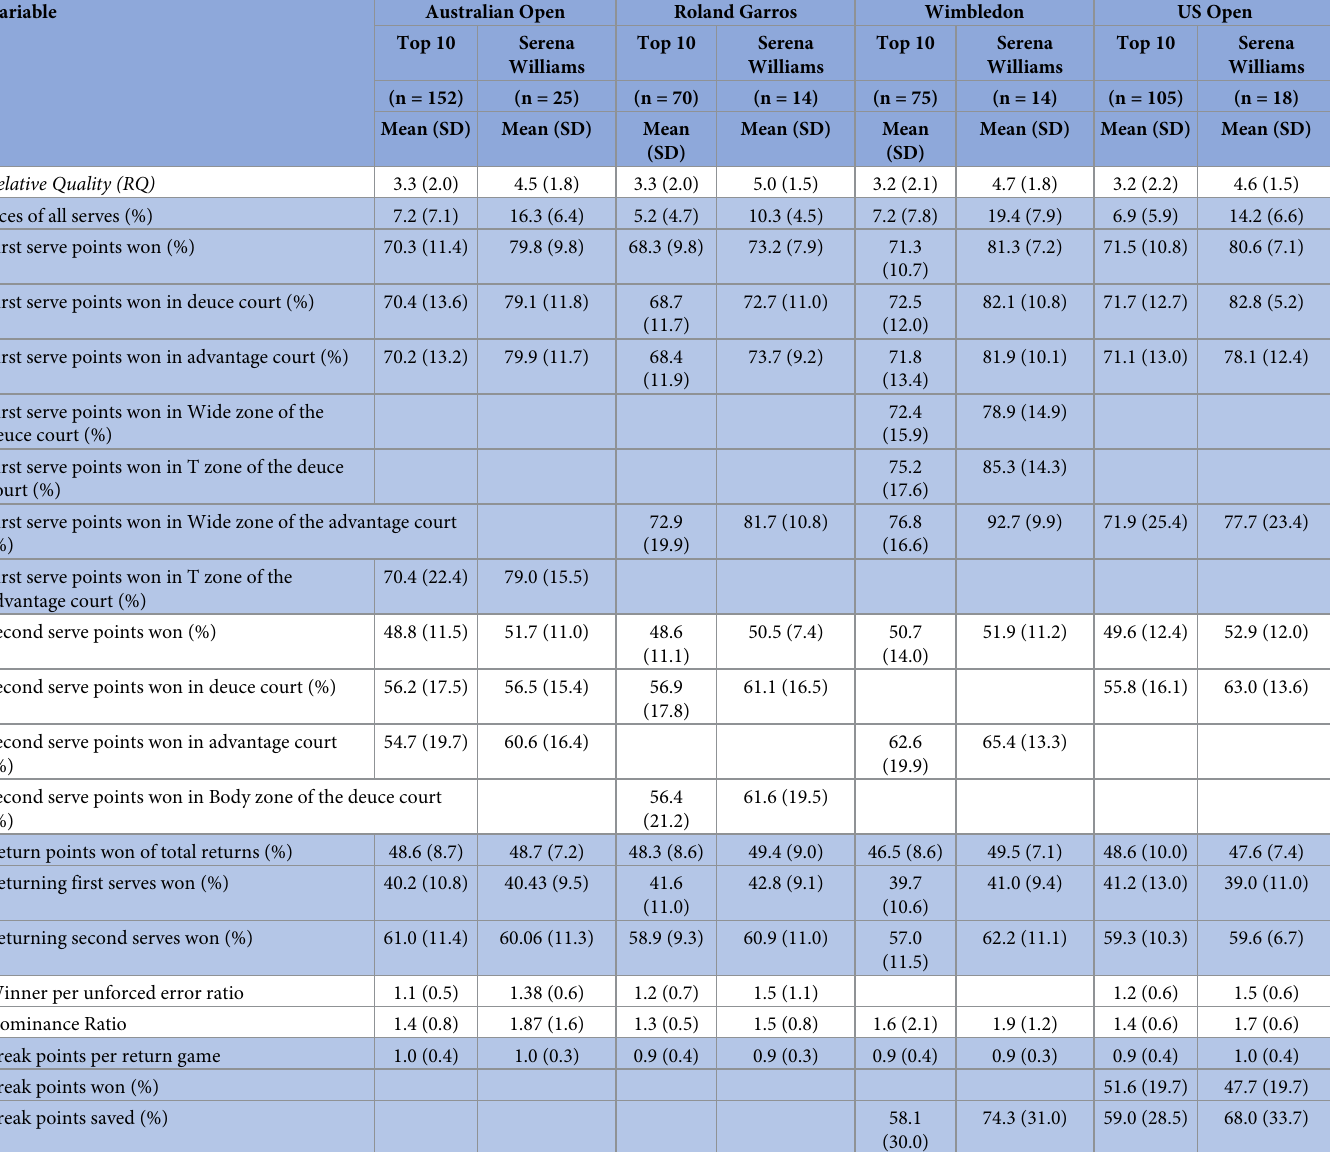
Table 3. Descriptive statistics of match performance and relative quality for Top-10 ranked female players and Serena Williams in four Grand Slams.